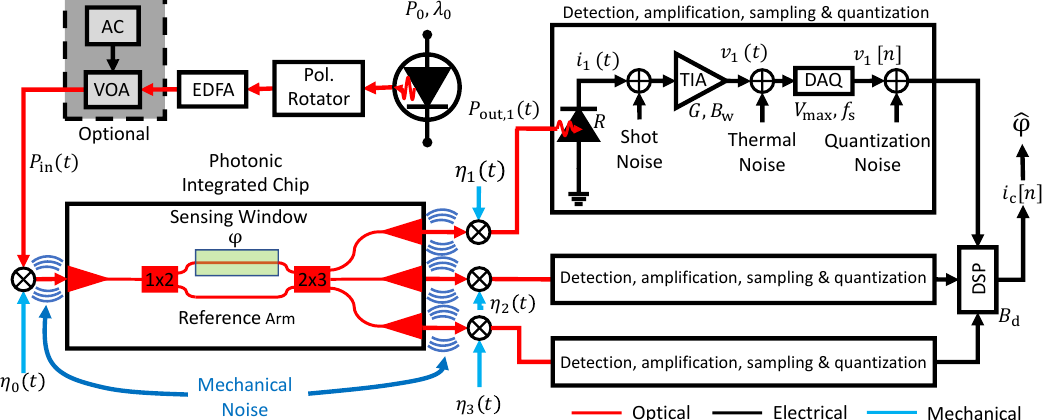
Figure 2. Setup of the employed interferometric sensing system, with mechanical and electrical noise sources. Mechanical vibrations result in time dependent coupling efficiencies η ( t ) to/from the sensor chip, while photo-detection, amplification, sampling and quantification add shot noise (SN), thermal noise (TN), aliasing and quantization noise (QN), respectively. The presence of noise hinders the accurate estimation ( ˆ ϕ ) of the sensed phase shift ( ϕ ) resulting in a deterioration of the limit of